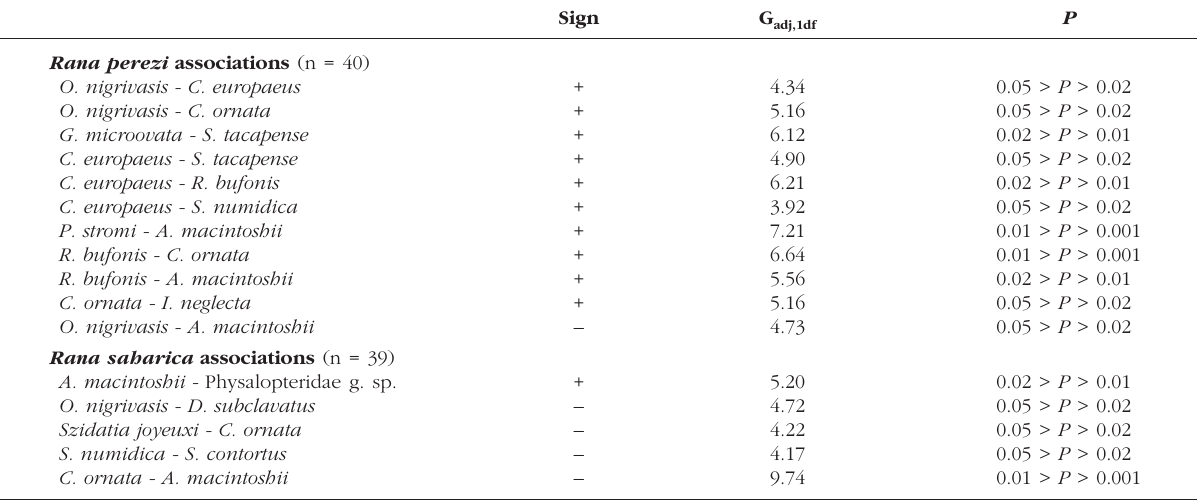
Table III. – Associations between pairs of helminth species in Rana perezi and Rana saharica